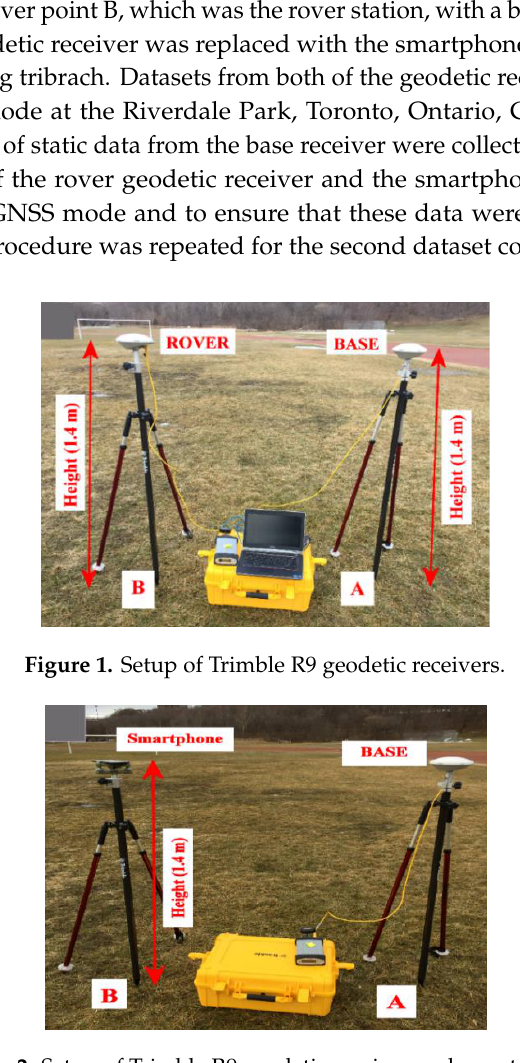
Figure 2. Setup of Trimble R9 geodetic receiver and smartphone.